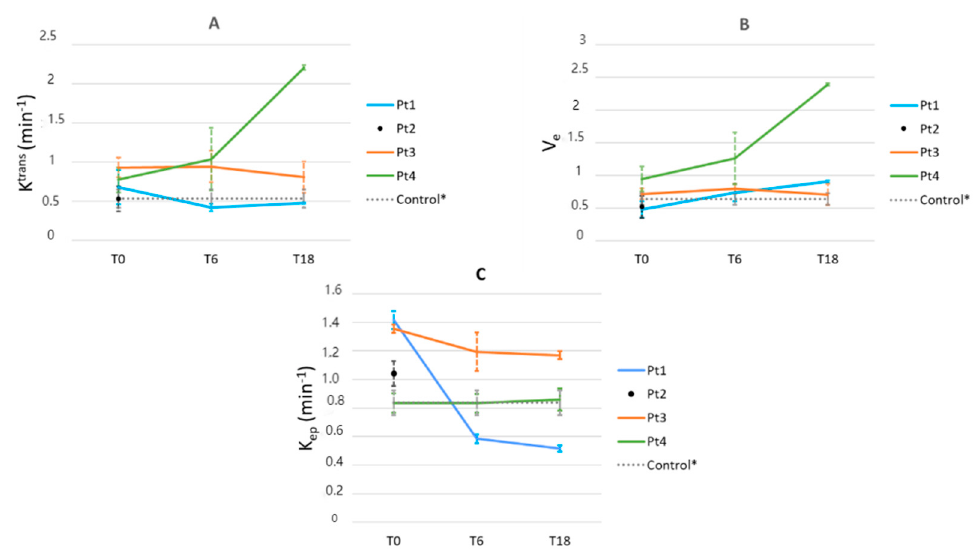
Figure 4. K trans and V e as measured by DCE-MRI. Mean values (+/–SD) for K trans , V e , and K ep across three vertebrae (Th7, Th9, and L1) of each individual patient are shown in panels ( A – C ), respectively. Vertical dashed lines represent the standard deviation of the mean of the measured values in the three individual vertebrae. NB: values of V e are > 1 in one patient. This is most probably a consequence of using a standard (thus not measured) Arterial Input function. * The healthy control was examined at baseline only; results were extrapolated for later time points.